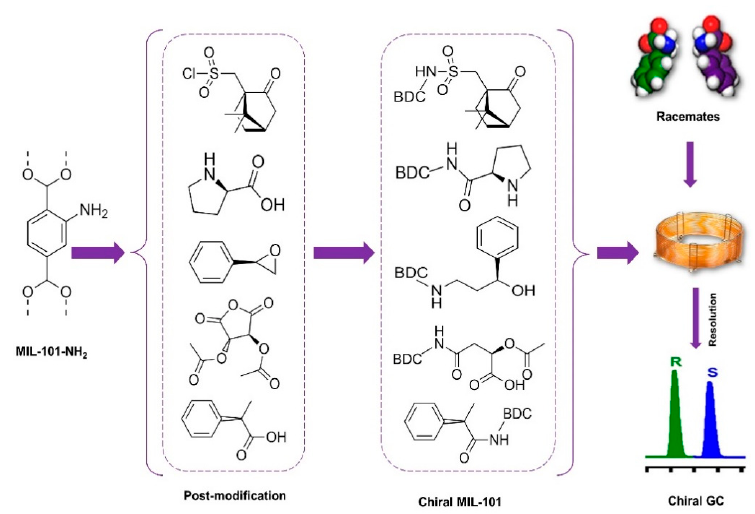
Figure 17. Scheme of the post-modification of chiral MIL-101(Al)-Xs and the construction of chiral GC by coated capillary columns [156]. Redraw by PowerPoint 365 software. GC by coated capillary columns [156]. Redraw by PowerPoint 365